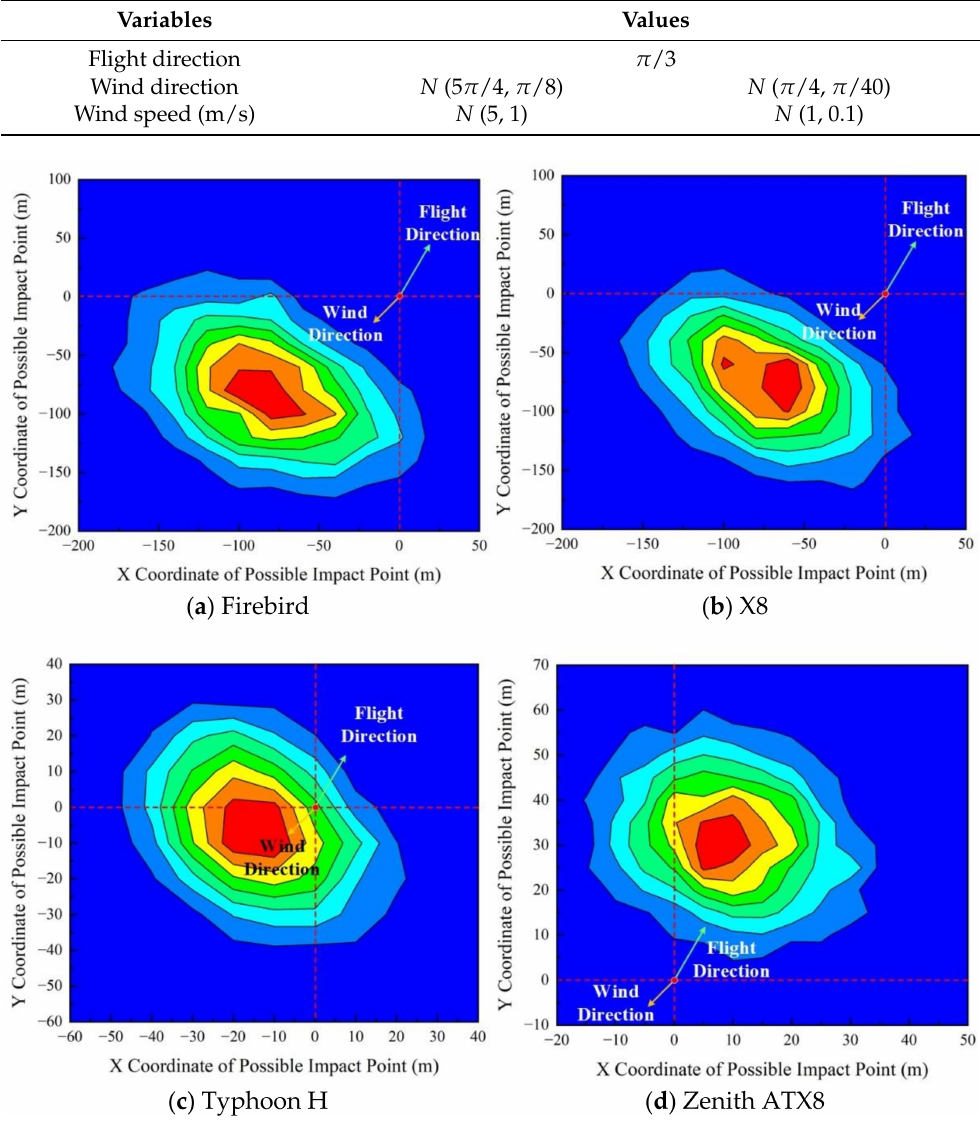
Figure 8. Possible ground impact positions with heavy